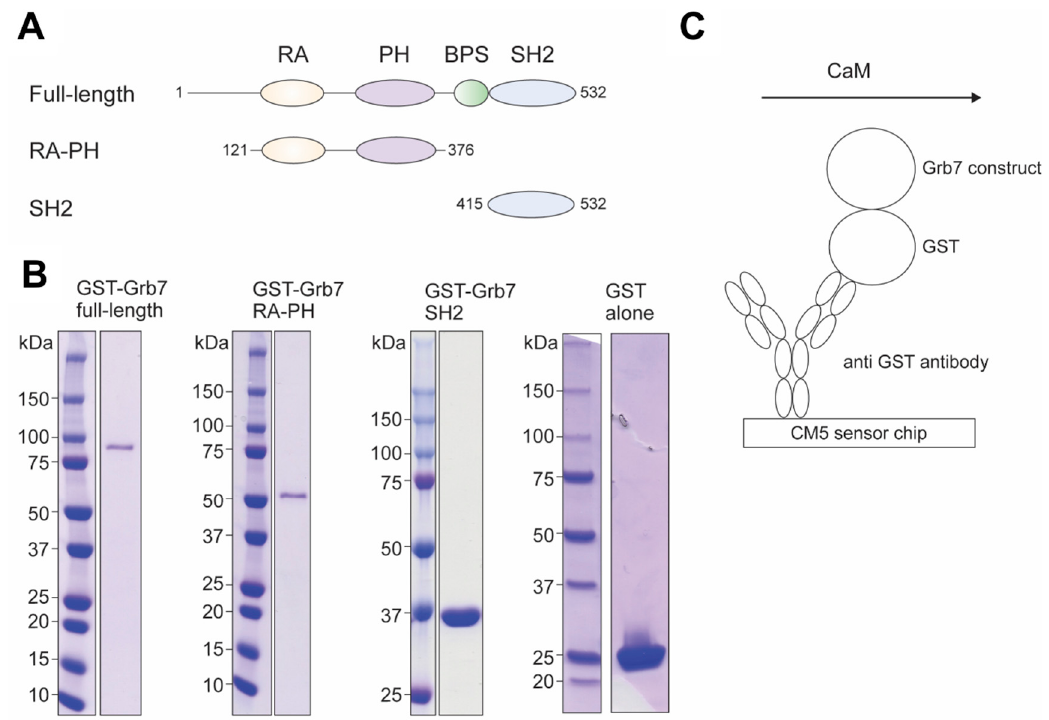
Figure 3. Preparation of Grb7 constructs. ( A ) The domain boundaries of Grb7 full-length, Grb7-RA-PH and Grb7-SH2 used for the preparation of GST-tagged proteins are shown. ( B ) SDS-PAGE analysis of the purified GST Grb7 constructs used for SPR experiments. ( C ) Schematic depicting the SPR experimental design. The GST Grb7 construct is captured on the surface of the biosensor chips via anti GST antibody. CaM is flowed across the surface of the chip under controlled buffer conditions, enabling interactions to be detected via SPR.